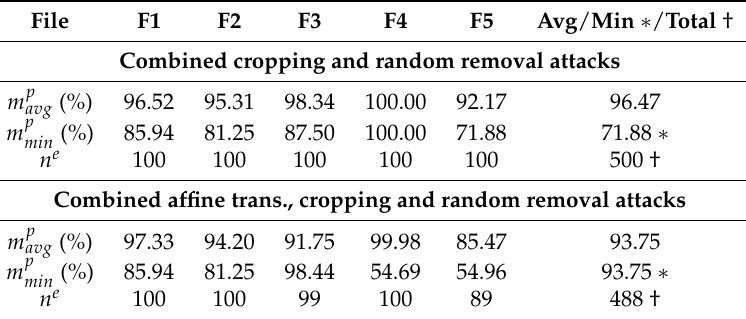
Table 6. Combined attacks with a random removal of points.